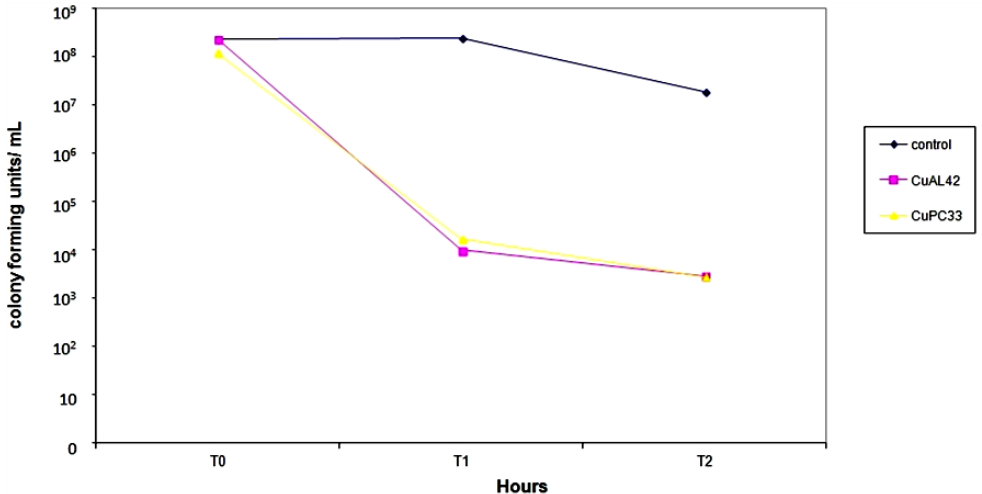
Figure 3. Mean Activity of CuAL42&CuPC33 against 53 clinical isolates of H. pylori . (AL42 = CuAL42; PC33 = CuPC33).